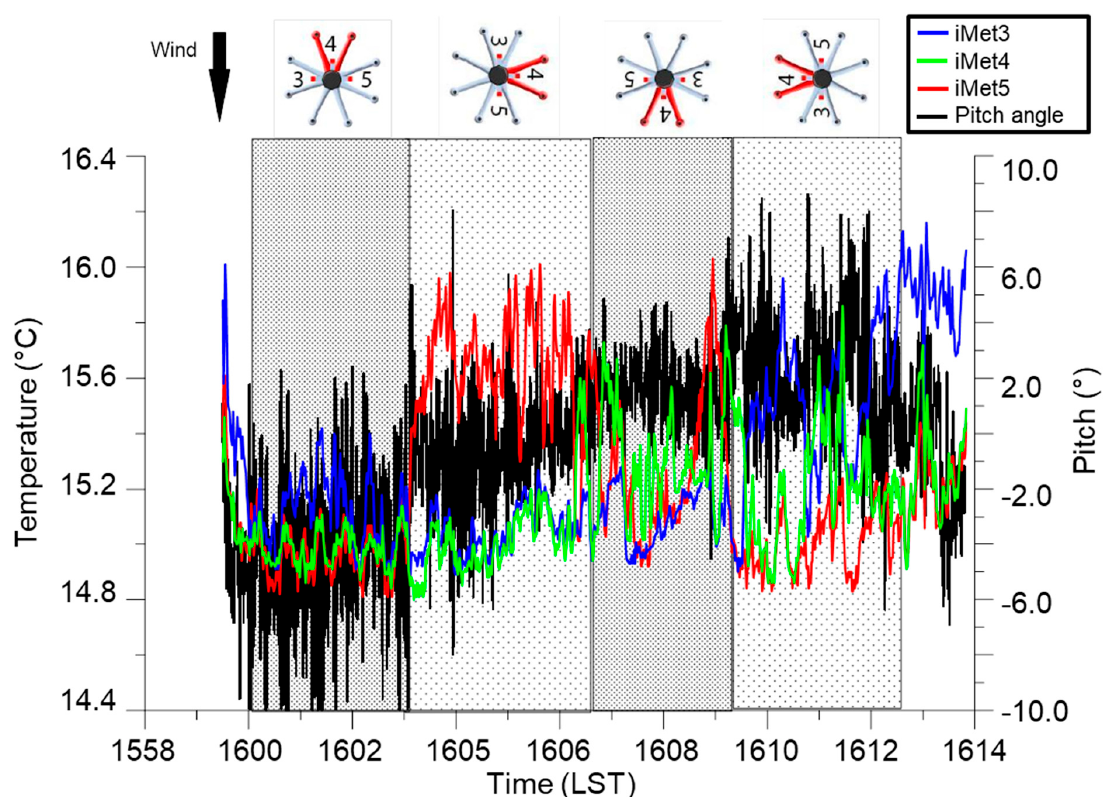
Figure 5. Inter-comparison among three iMet-XQ temperature sensors as a function of orientation into wind of the DJI S-1000 sUAS. Blue, green, and red lines show temperature measurements of the iMet-XQ sensors 3, 4, and 5, respectively, and the black line shows the pitch of the sUAS during flight. Positions of these sensors on the topside of the sUAS with respect to the sUAS orientation and wind direction are shown at the top of the figure.